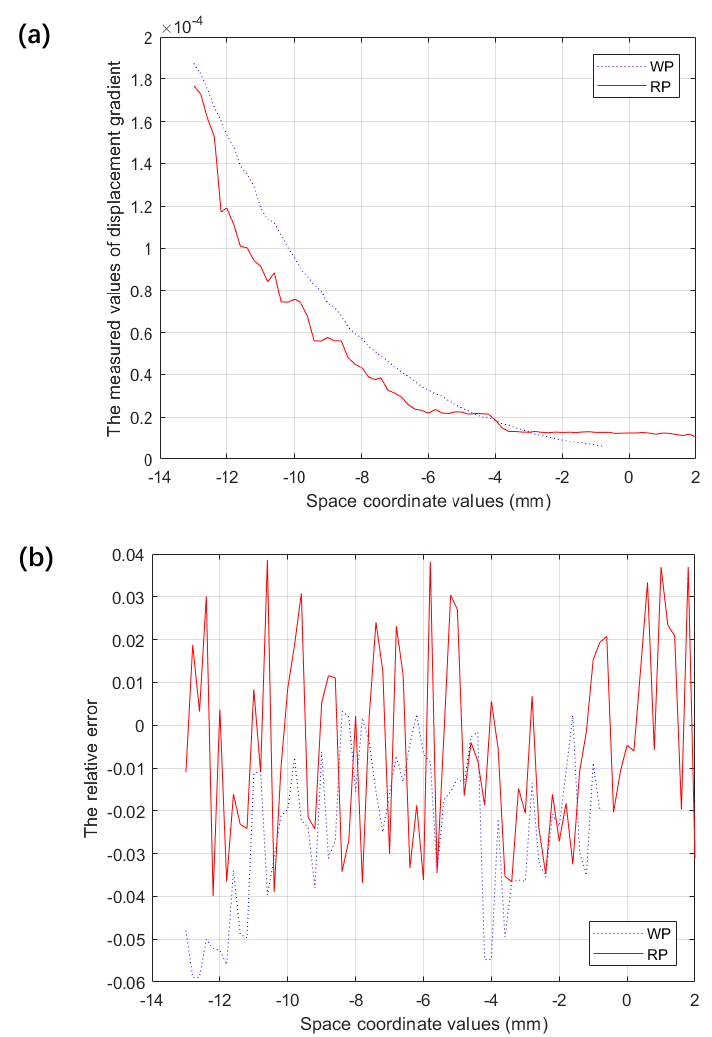
Figure 8. The ( a ) measured values and ( b ) relative errors of RP and WP along the x-axis.